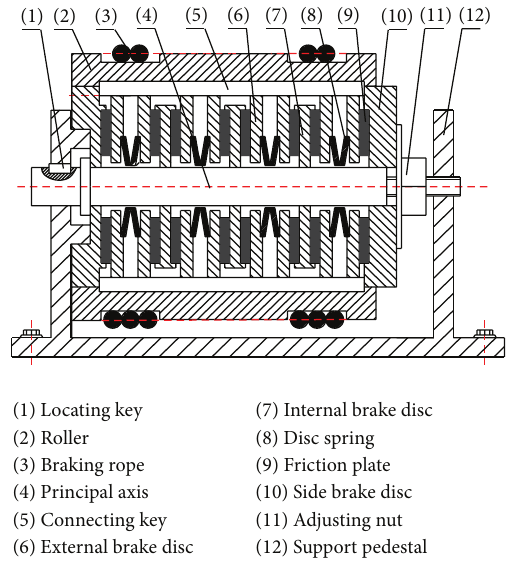
Figure 2: Structure sketch of multidisc energy